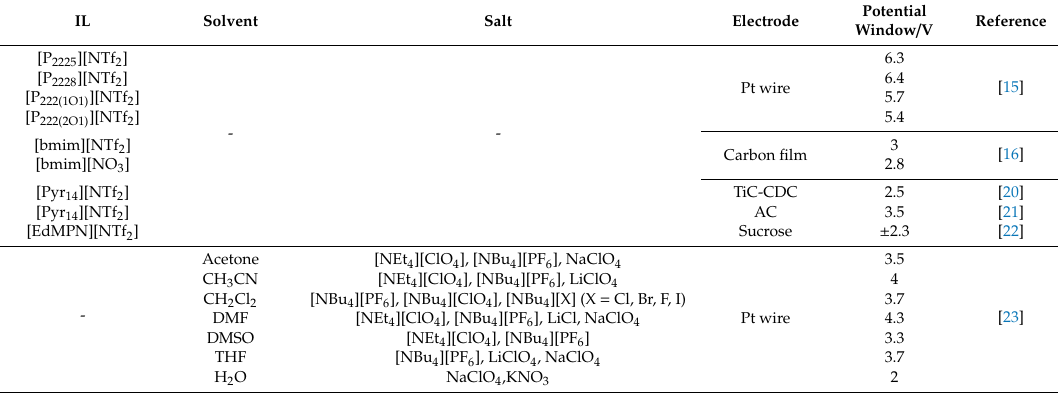
Examples of electrochemical potential window of selected phosphonium- and imidazolium-based ionic liquids and standard aqueous and non-aqueous